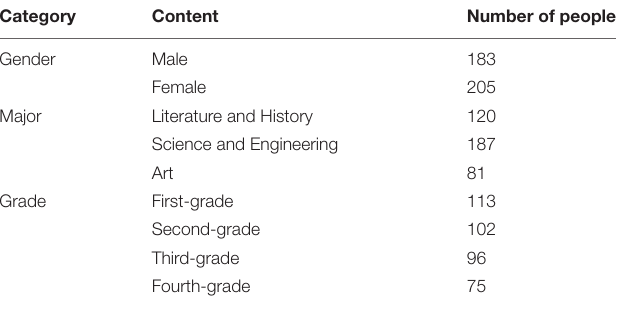
TABLE 1 | Basic information on research samples.